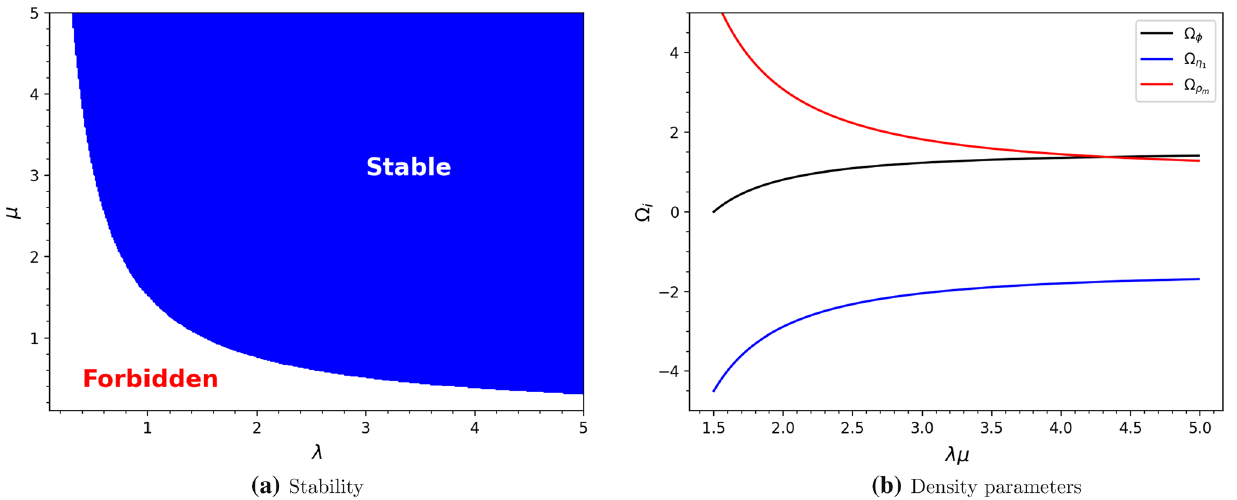
panel, the graph b illustrates the relation between density parameter of 1 non-vanishing fields and free parameters, i.e., λ and μ . The black, blue and red line in graph b indicates (cid:12) φ , (cid:12) η